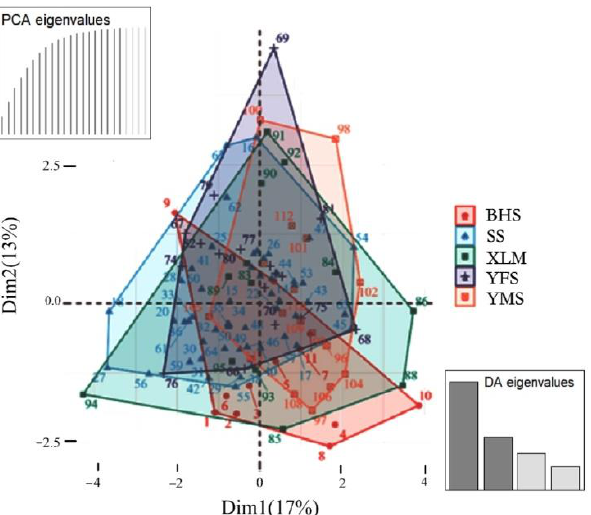
Figure 3. Genetic similarity based on DAPC analysis of microsatellite genotypes in leopard cat subpopulations in the five sampling areas. BHS represents Baihuashan in red, SS represents Songshan in blue, XLM represents Xiaolongmen in green, YFS represents Yunfengshan in gray, and YMS represents Yunmeng- shan in